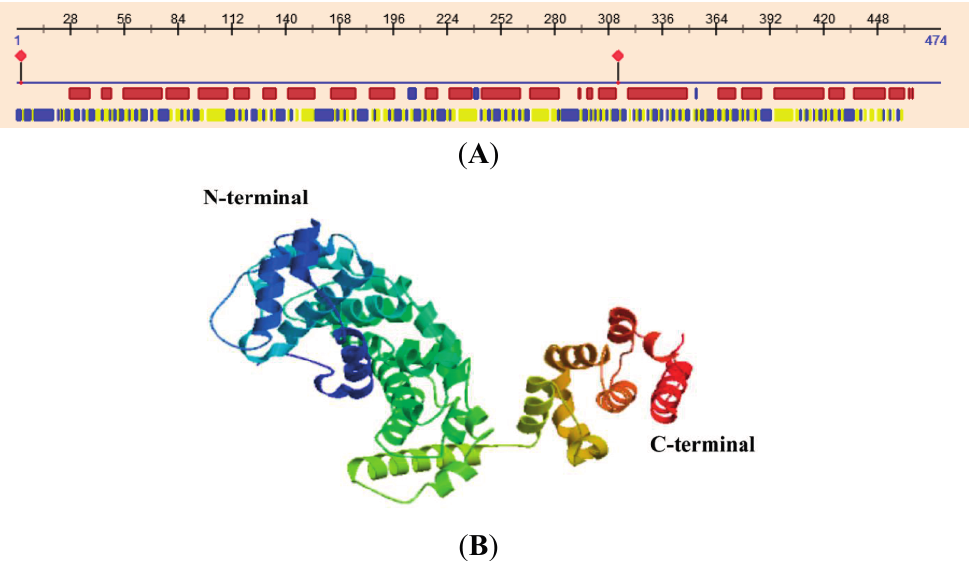
Figure 5. Secondary and tertiary structure of MsV1H. ( A ) Secondary structure of MsV1H. The first line shows the secondary structure of MsV1H from RePROF prediction methods. Red boxes indicate helix, while blue boxes indicate strand. The second line shows the residues that expose to the outside or buried inside of the protein. Blue boxes and yellow predicted protein binding sites; ( B ) Tertiary structure of MsV1H produced by